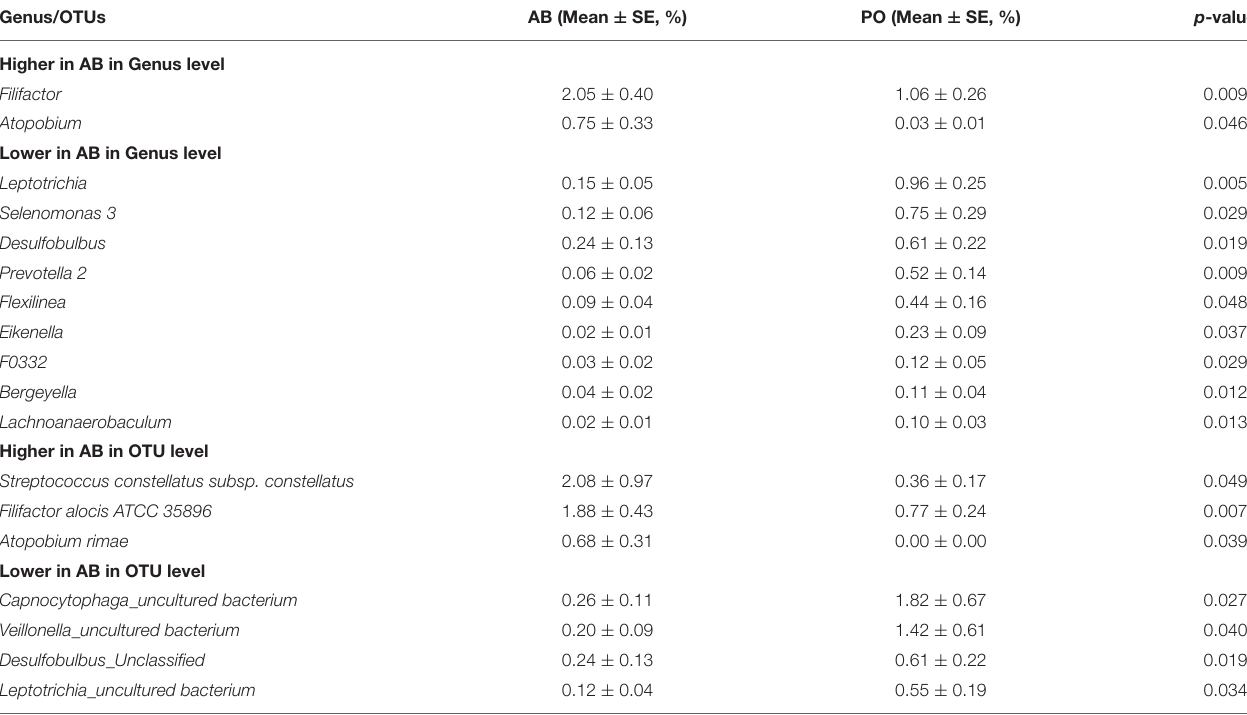
TABLE 3 | Specific bacteria of significant difference in AB compared with PO group based on a paired t -test at group level.